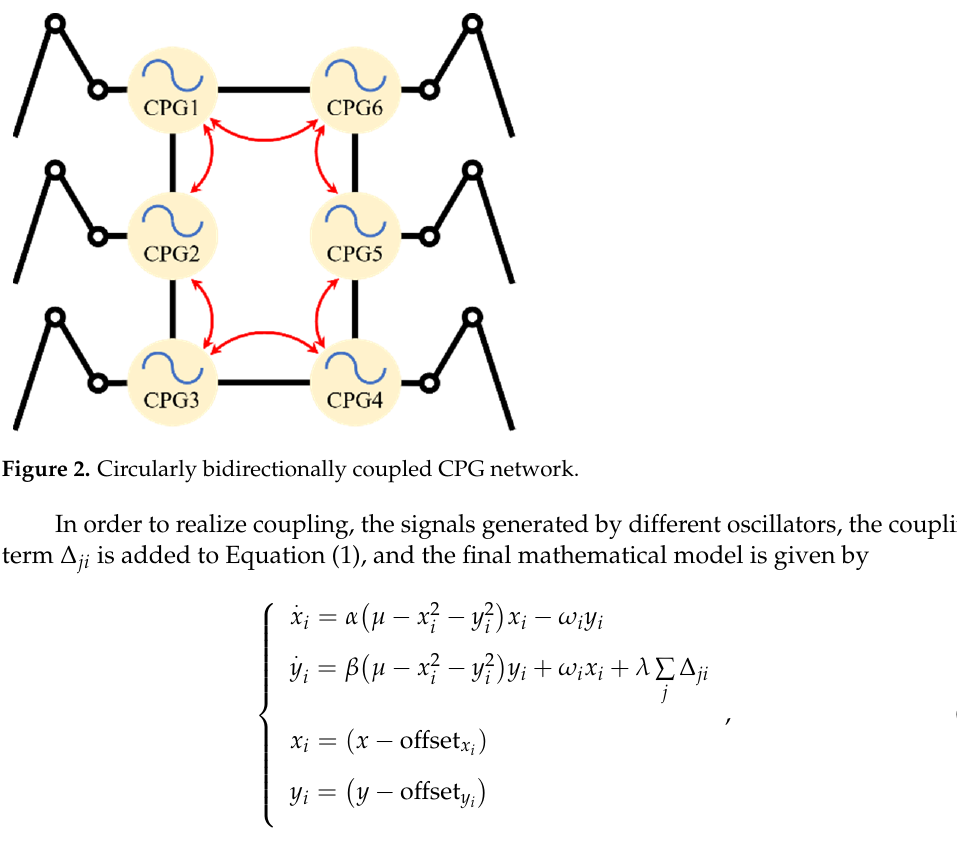
Figure 3. The phase di ff erence corresponding to common gaits. The transition from the output signal of the oscillator to the control signal of the robot joint requires a mapping that transforms the signal into a foot trajectory and then com- putes the joint angle via inverse kinematics. The mapping function is de fi ned as follows: